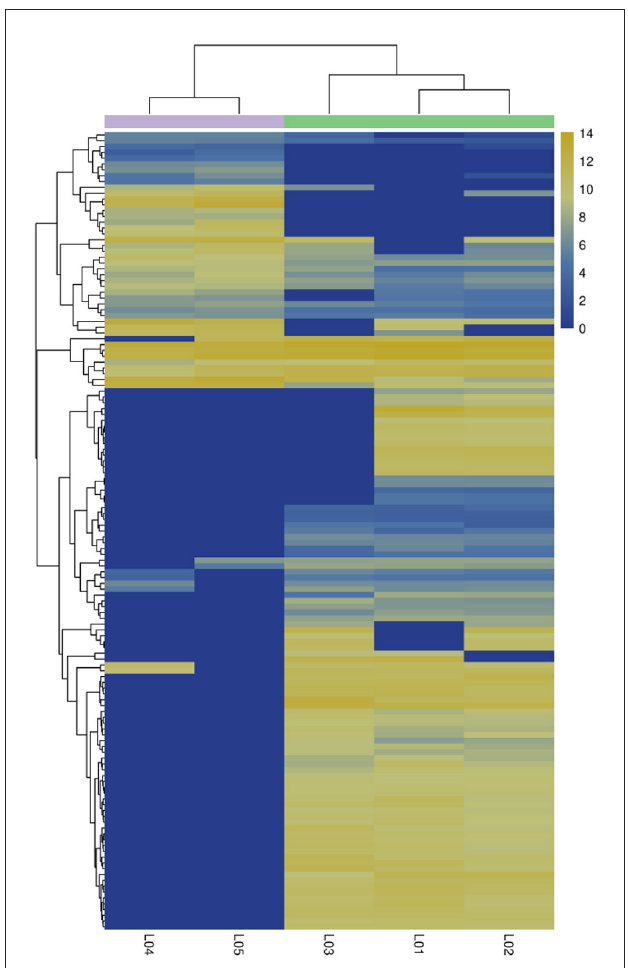
FIGURE6 Correlation heat map. Different columns in the figure represent different samples, and different rows represent DE circRNAs. The color represents the expression level of circRNA in the sample (log2tpm + 1).